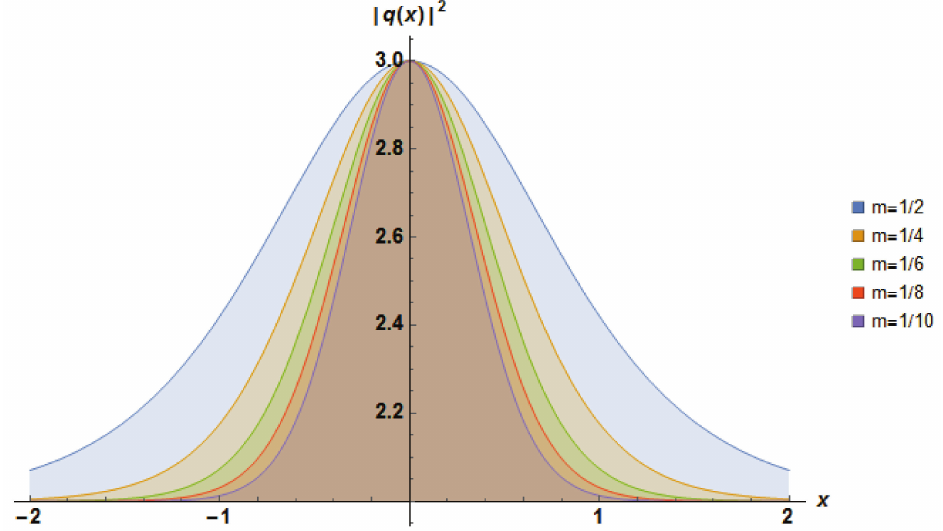
Figure 2. Profile of a stationary bright